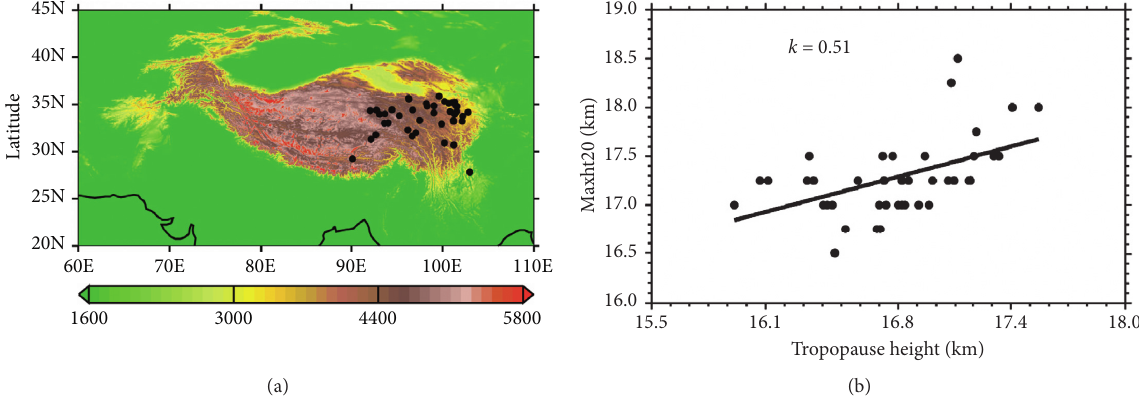
Figure 1: (a) The spatial distribution of topography (units: m). The black dots indicate geographical locations of the 41 OCS events in summer derived TRMM PFs with 20 dBZ echo tops reaching above the lapse rate tropopause during 1998–2013 over the TP. (b) Scatter plot of Maxht20 (units: km) and tropopause height (units: km) above sea level derived from 41 OCS events.